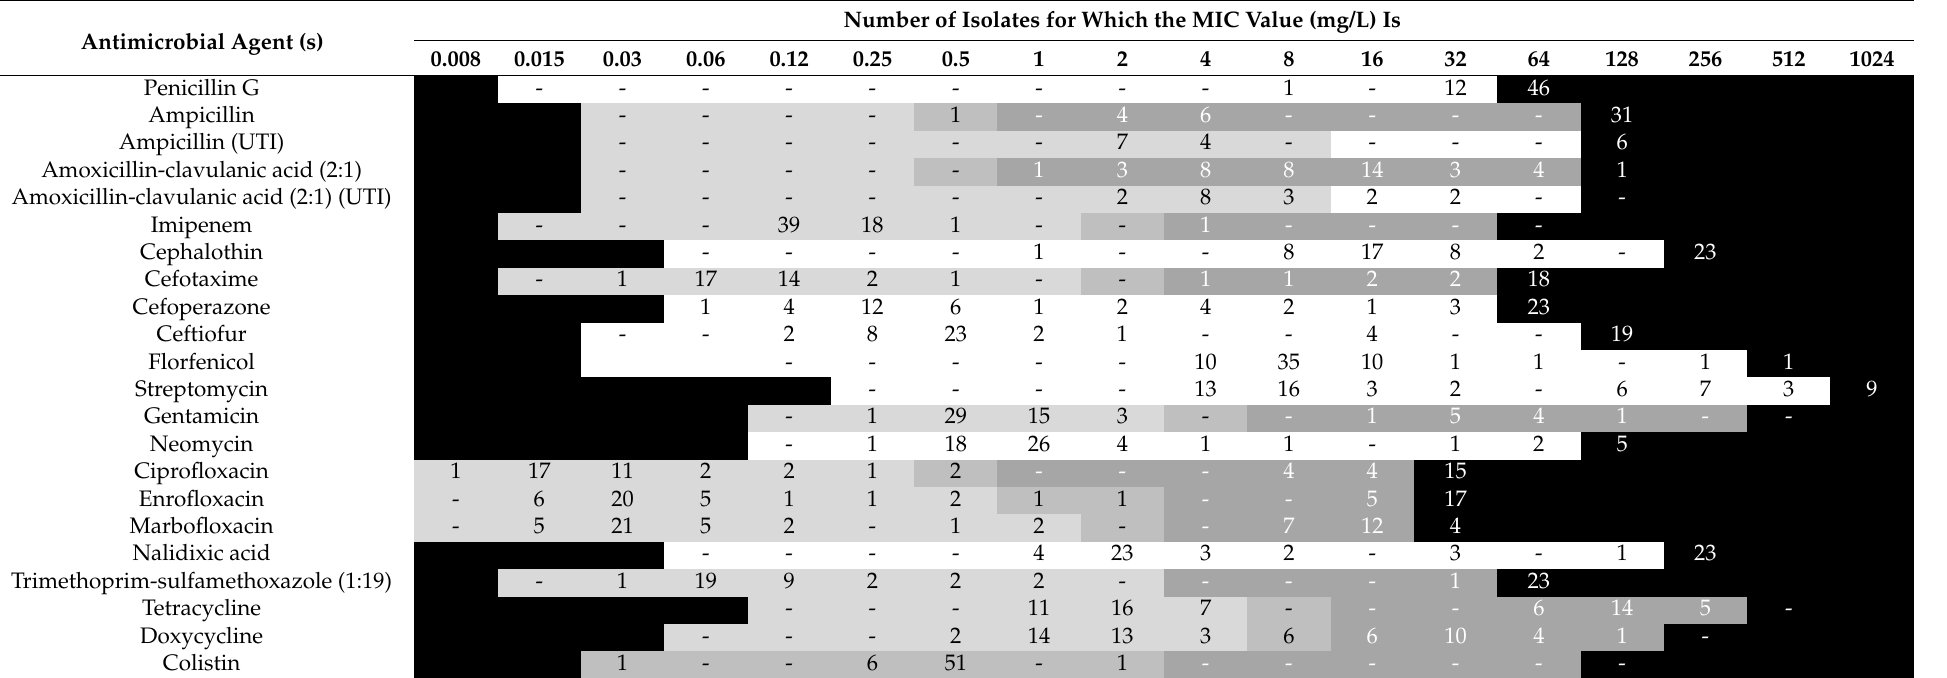
Table 3. Minimal inhibitory concentrations of the 59 canine and feline E. coli